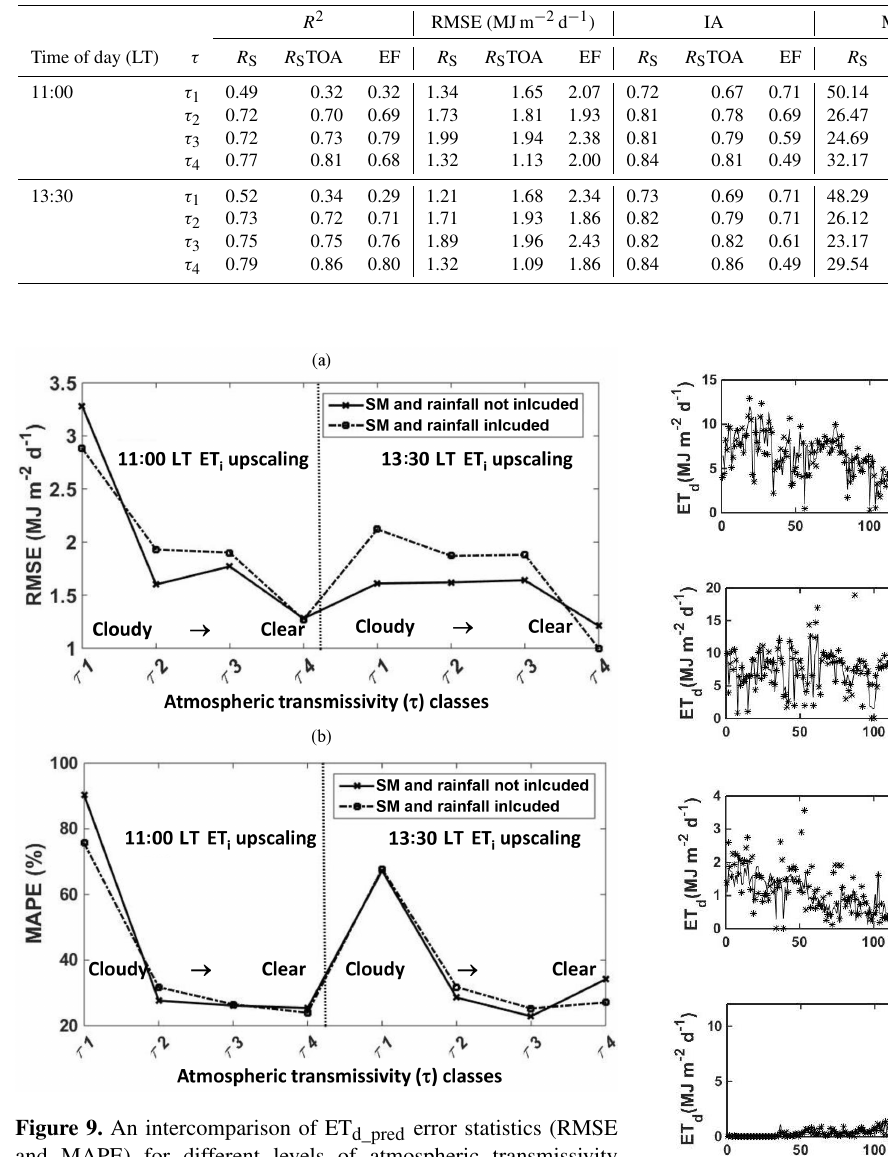
lowest RMSE (1.09 and 1.13 MJ m − 2 d − 1 ) in ET d_pred com-